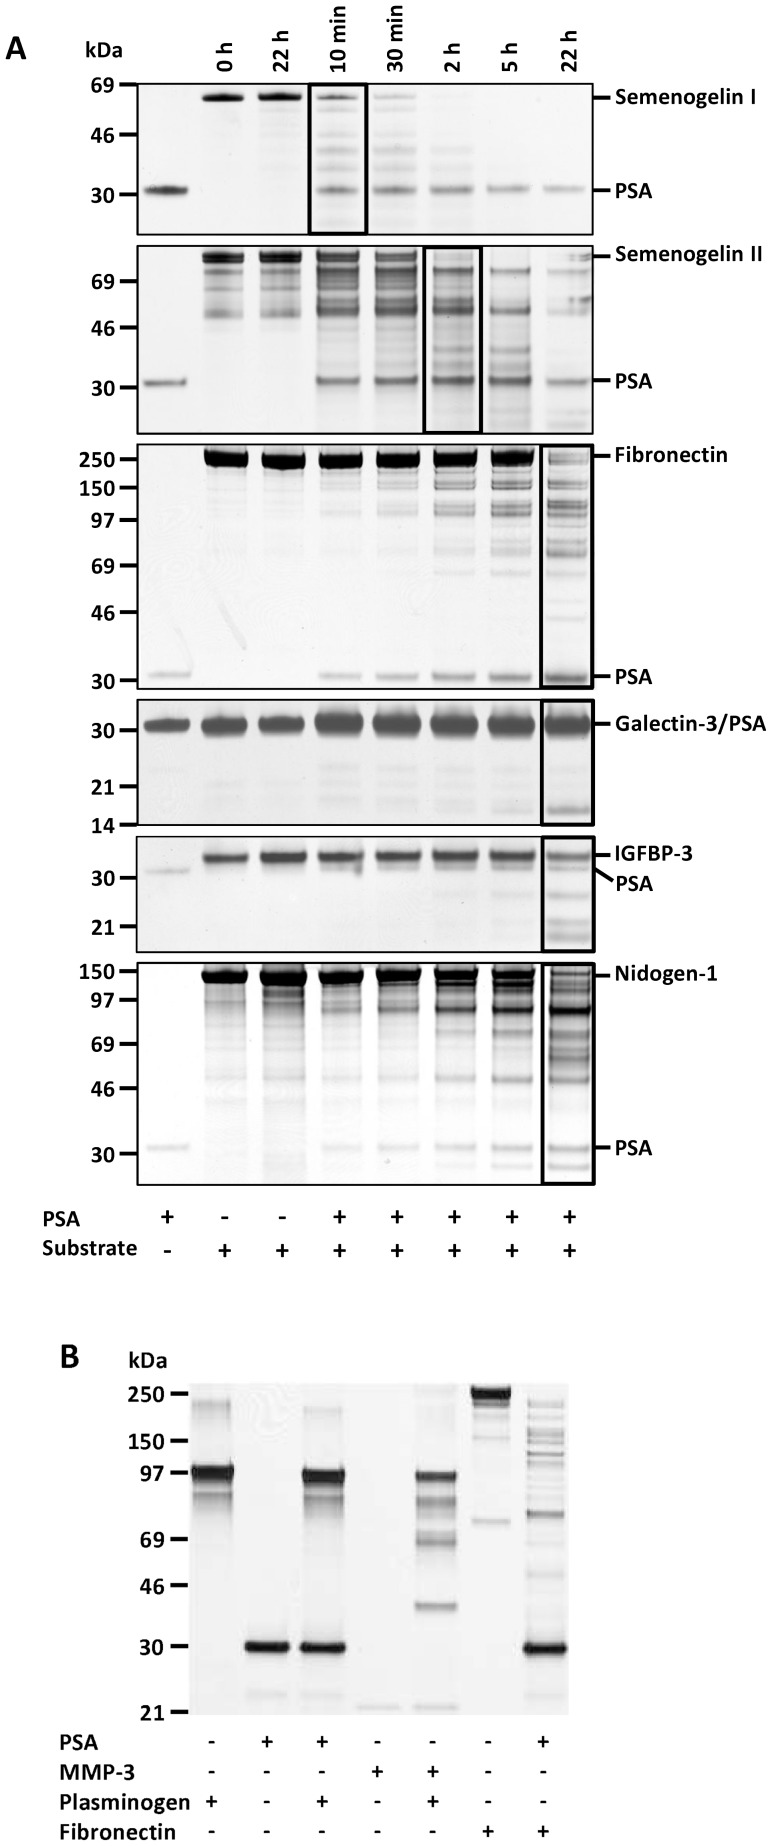
Cleavage of protein substrates by PSA.(A) Characterization of the proteolytic activity of PSA (0.2 µM) during 22 h incubation towards different protein substrates (1 µM each, except 0.5 µM semenogelin I) by SDS-PAGE and silver staining. Approximate molecular weights of the proteins are: PSA (28 kDa), semenogelin I (50 kDa), semenogelin II (63 kDa), fibronectin (220 kDa), galectin-3 (26 kDa), IGFBP-3 (30 kDa) and nidogen-1 (130 kDa). The lanes in which ∼50% of the proteins were cleaved are bordered. (B) 1 µM MMP-3 (22 kDa), but not PSA, cleaved 1 µM plasminogen (88 kDa). Also 0.5 M fibronectin was incubated with 1 µM PSA as a control (SDS-PAGE with silver staining).